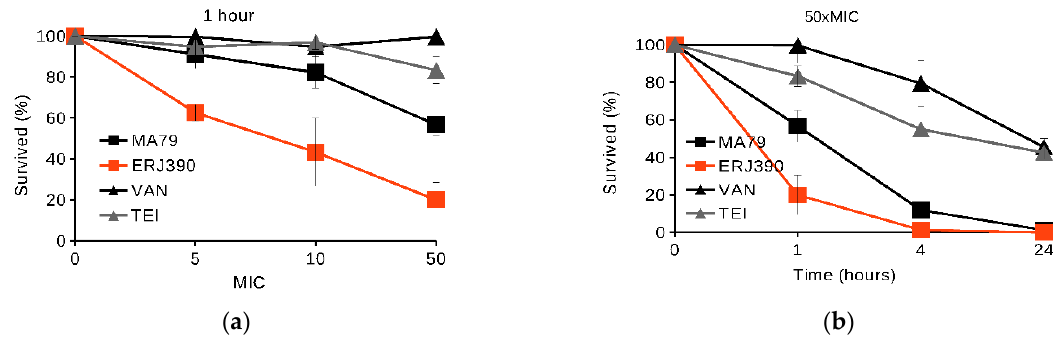
Figure 3. Killing of S. aureus 8325 cells in stationary phase by antibiotics vancomycin (VAN), teicoplanin (TEI), MA79, and ERJ390 at one hour after treatment of the bacteria with the antibiotics at various concentrations exceeding the MIC ( a ) and at time points after treatment of the bacteria with the antibiotics at a concentration exceeding the MIC 50-fold ( b ).